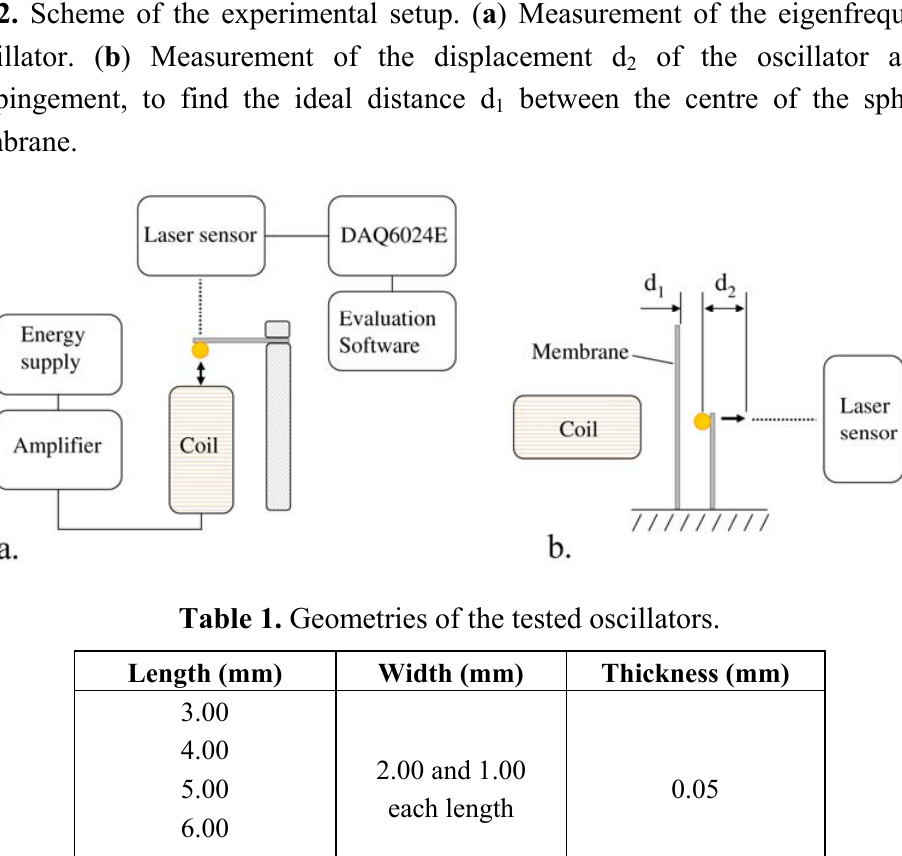
of the oscillator after the 2 between the centre of the sphere and 1